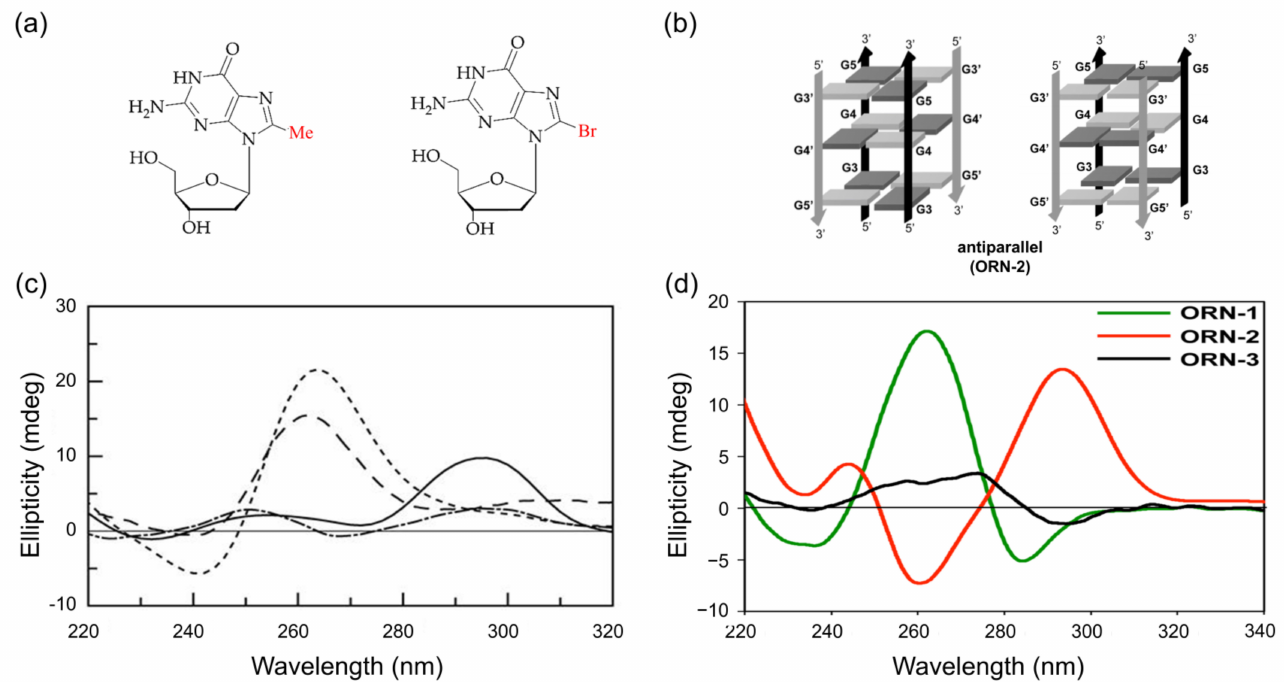
Figure 8. ( a ) Graphical representation of 8-methylguanosine and 8-arylated guanosine; ( b ) stabilized anti-parallel struc- tures of G-quadruplexes in K+ solution; ( c ) CD spectra of G-quadruplex sequence, which contains 8-methyl guanosine: ([d(TGGGT)] 2 ) at 20 ◦ C (dotted), Q1 at 20 ◦ C (solid), Q2 at 20 ◦ C (dashed), and Q3 at 5 ◦ C (dashed dot); ( d ) CD spectra of ORN-1 (UA(8 Br rG)GGU, red solid line, parallel G4 structure), ORN2 (UAG(8 Br rG)GU, green solid line, anti-parallel G4 structure), and ORN3 (UAGG(8 Br rG)U, black solid line, single-strand structure). Copyright (2017) Springer Nature, and (2005) Oxford University